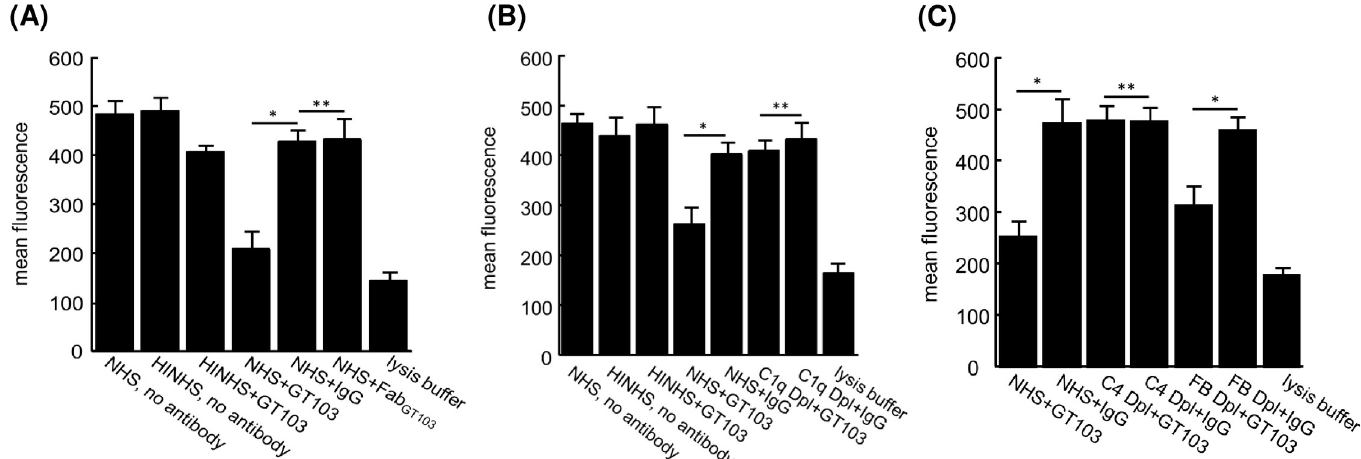
Fig 5. GT103 mediates complement lysis of exosomes by the classical pathway. Exosomes isolated from the conditioned medium of NCI-H460 cells were conjugated to anti-CD63 beads and labeled with calcein. Antibodies were added at 200 μ g/ml. Mixtures were incubated for 1 hr on ice, then 10% normal human serum (NHS), heat- inactivated serum (HINHS), or a complement factor-depleted serum was added. After incubation for 1 hr at 37˚C calcein fluorescence was analyzed by flow cytometry. As a positive control, exosome-bead conjugates were treated with lysis buffer for 10 min. Each condition was performed in triplicate. Exosome lysis is indicated by a reduction in fluorescence. (A) Lysis in the presence of GT103 or GT103-derived Fab; (B) Lysis in the presence of NHS or C1q depleted serum; (C) Lysis in the presence of NHS or C4 or Factor B depleted serum Data are represented as mean +/- SD. � P < 0.05; �� P > 0.05.